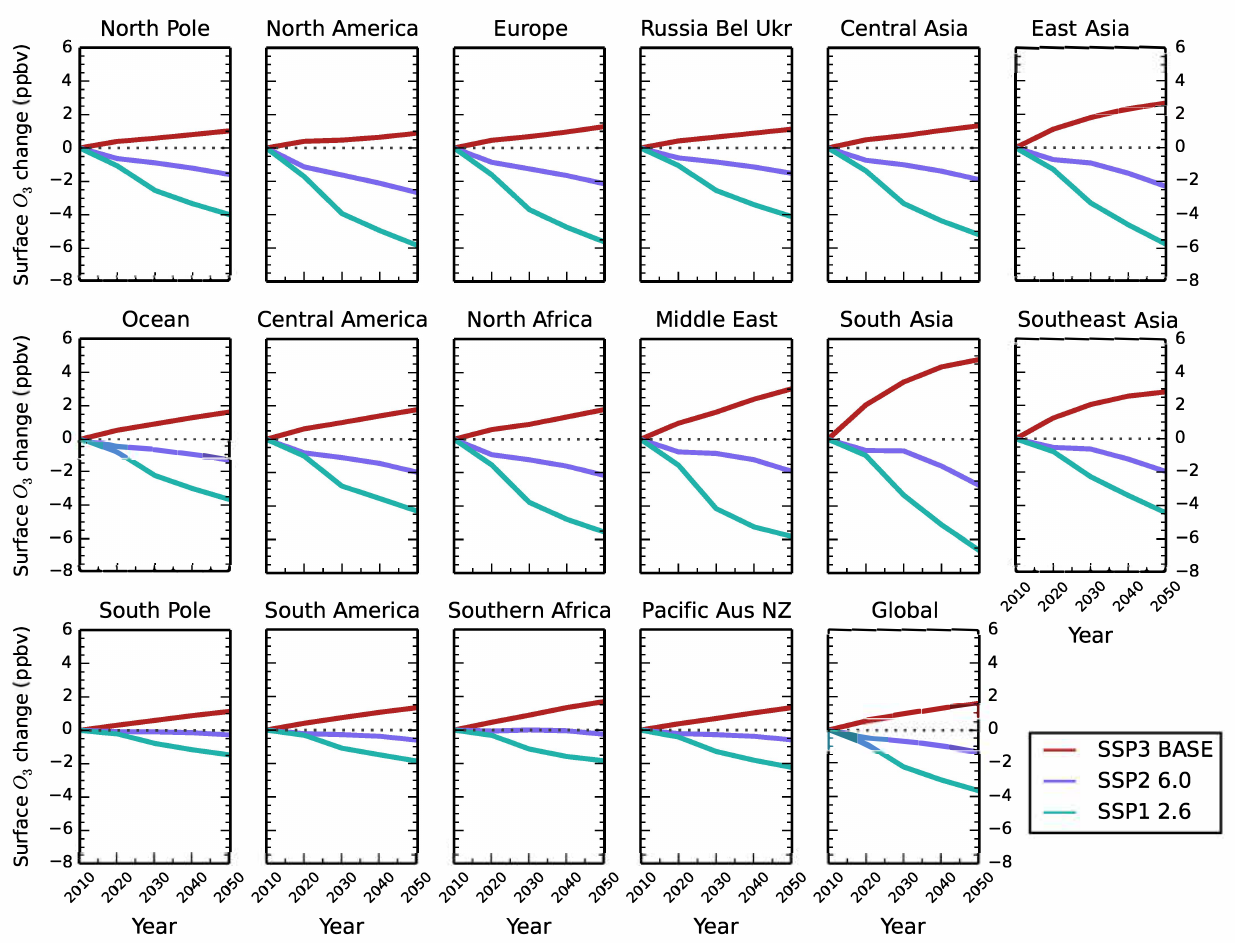
Figure 9. Annual mean change in regional surface O 3 concentrations between 2010 and 2050 from the parameterisation for the CMIP6 emission scenarios of Shared Socioeconomic Pathway 3 (SSP3) baseline (red), SSP2 with a radiative forcing target of 6.0Wm − 2 (purple) and SSP1 with a radiative forcing target of 2.6Wm − 2